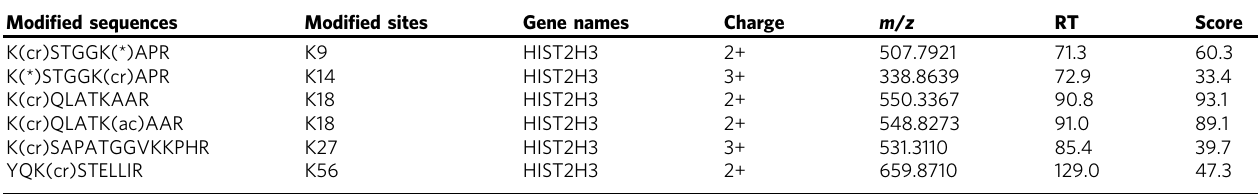
Table 1 List of K-crotonyl histone-modi fi ed peptides Modi fi ed